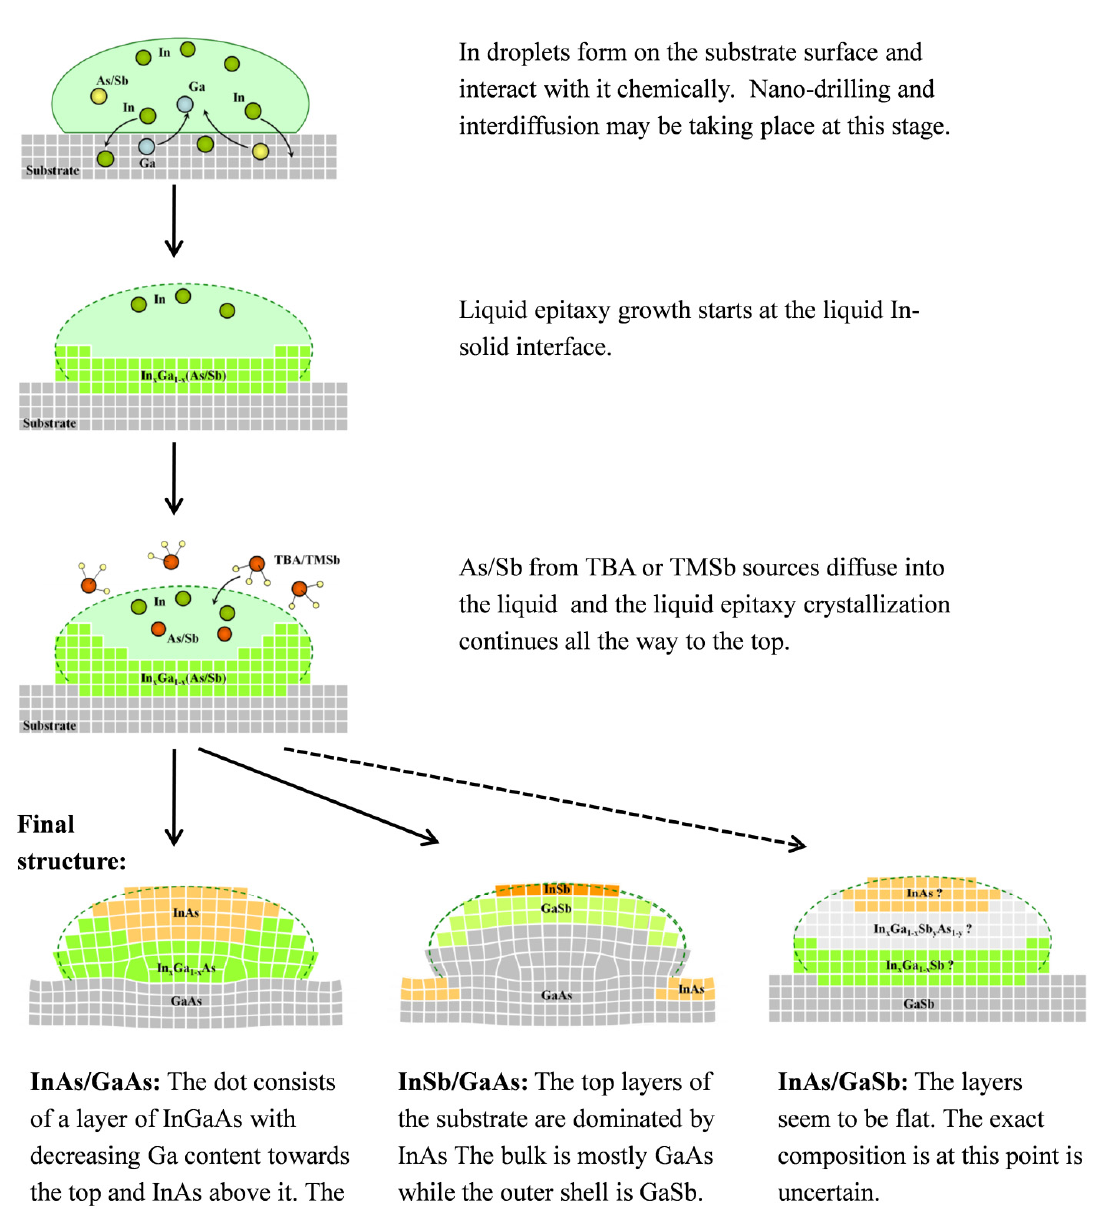
Figure 5. Schematic illustration of the suggested model of the DHE growth process. The final structure is different for the three different systems